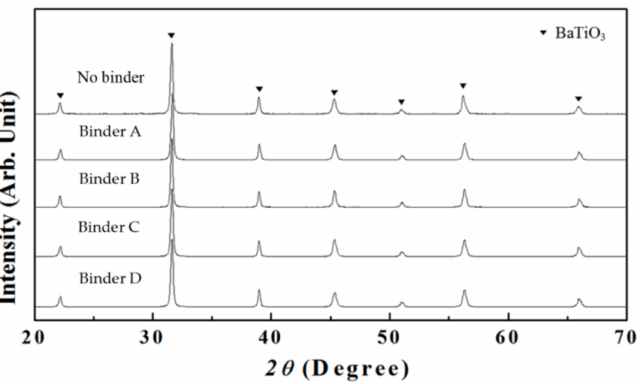
Figure 4. XRD patterns of the 0.1 wt.% Dy 2 O 3 -doped 0.98BaTiO 3 -0.02(Ba 0.5 Ca 0.5 )SiO 3 ceramics sintered at 1320 ◦ C for 1 h with different binders.